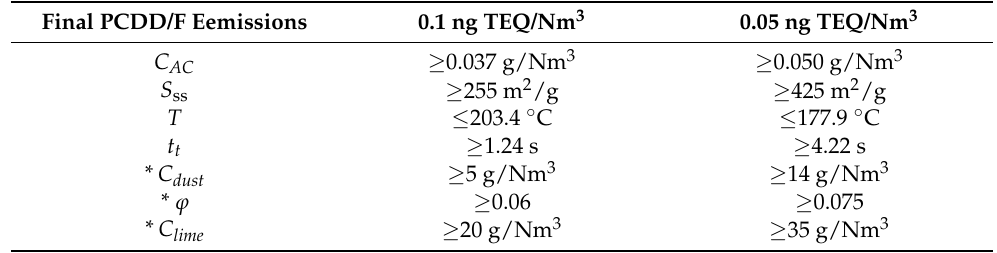
Table 1. Operating parameters for attaining the standards of 0.1 ng TEQ/Nm 3 and 0.05 ng TEQ/Nm 3